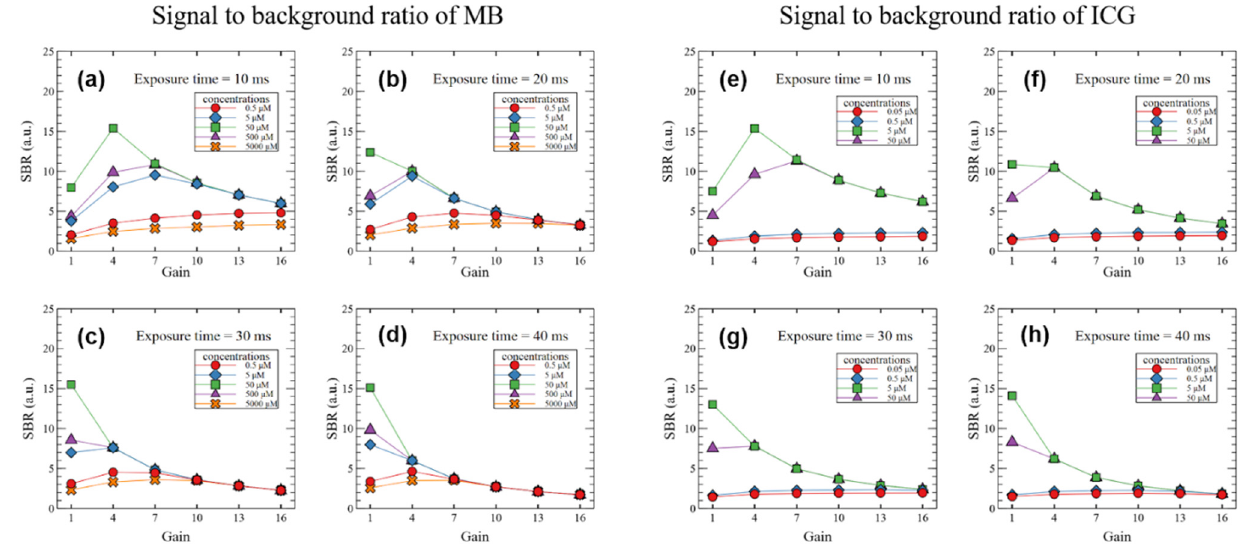
Figure 8. SBR of ( a – d ) MB and ( e – h ) ICG according to the concentrations of the two fluorescent contrast agents and the exposure time and gain of the camera.